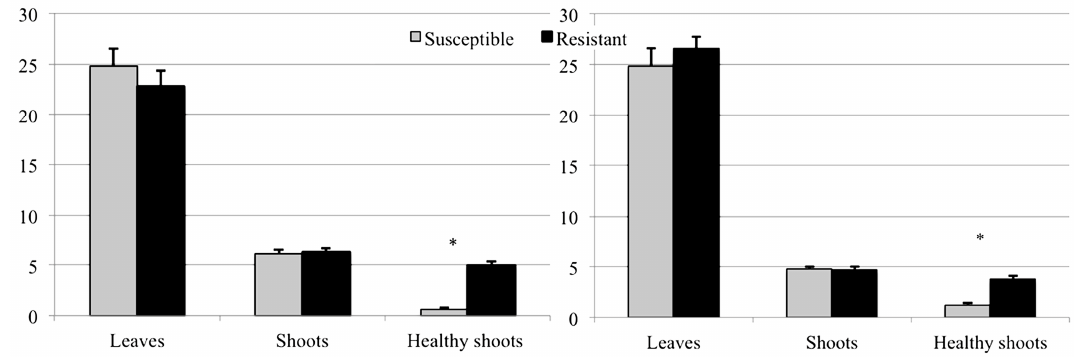
Figure 4. Mean number of leaves >2 cm, shoots (healthy and infested), and healthy shoots sampled on RSE and susceptible chestnuts in 2016 ( left ) and 2017 ( right ). Bars with * are significantly different at the 5% level, as determined by ANOVA test.